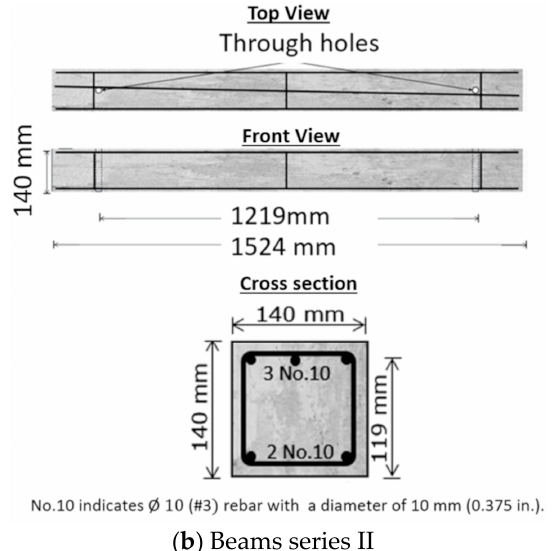
Figure 3. Beam reinforcing details: ( a ) series I and ( b ) series II.